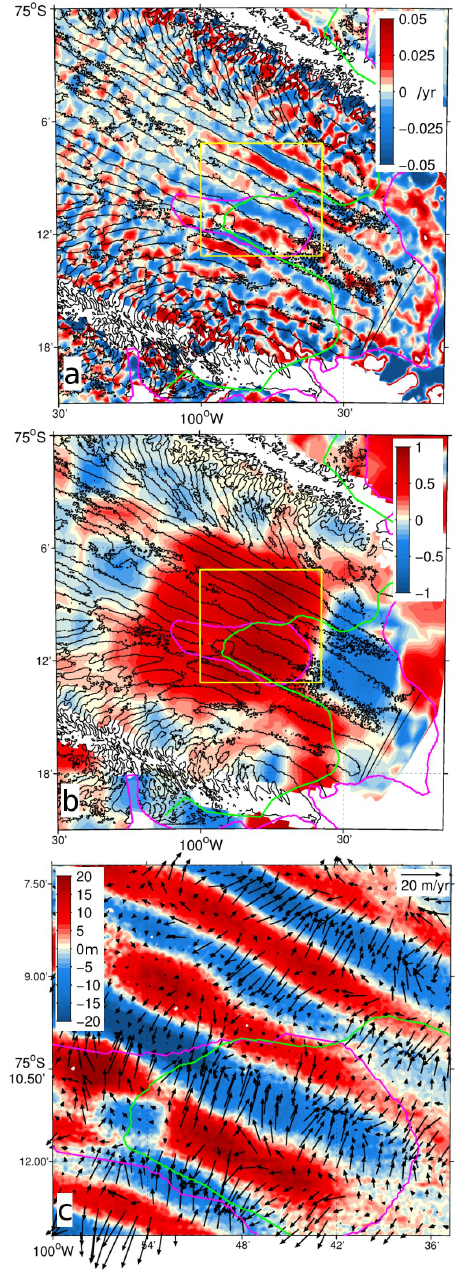
Fig. 4. (a) Small-scale anomalies in ice surface velocity divergence (yr − 1 ) using November 2008 estimates of ice velocity; Overlaid contours show 0m ice surface elevation anomaly from Fig. 2a after translation to correct for ice movement between March and Novem- ber 2008. Same contour applies in (b) . The yellow box indicates the area in (c) . (b) Correlation over moving 4km 2 square boxes be- tween surface elevation and velocity divergence anomalies in (a) . (c) Zoom showing surface elevation anomaly (black contours in Fig. 3a and b) and associated velocity anomaly vectors explaining the divergence field in (a)